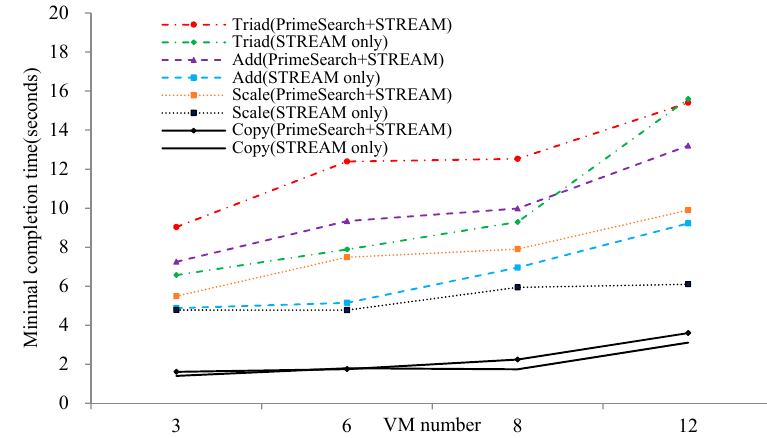
Figure 14. Minimum completion time of STREAM (server #3).